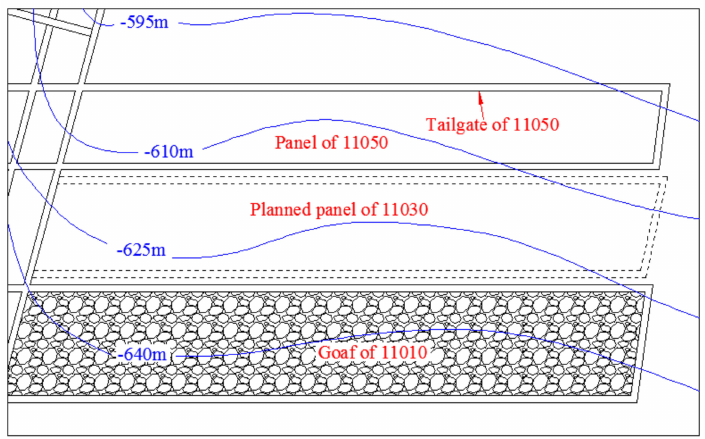
Figure 2. The plan view of the panel layout.